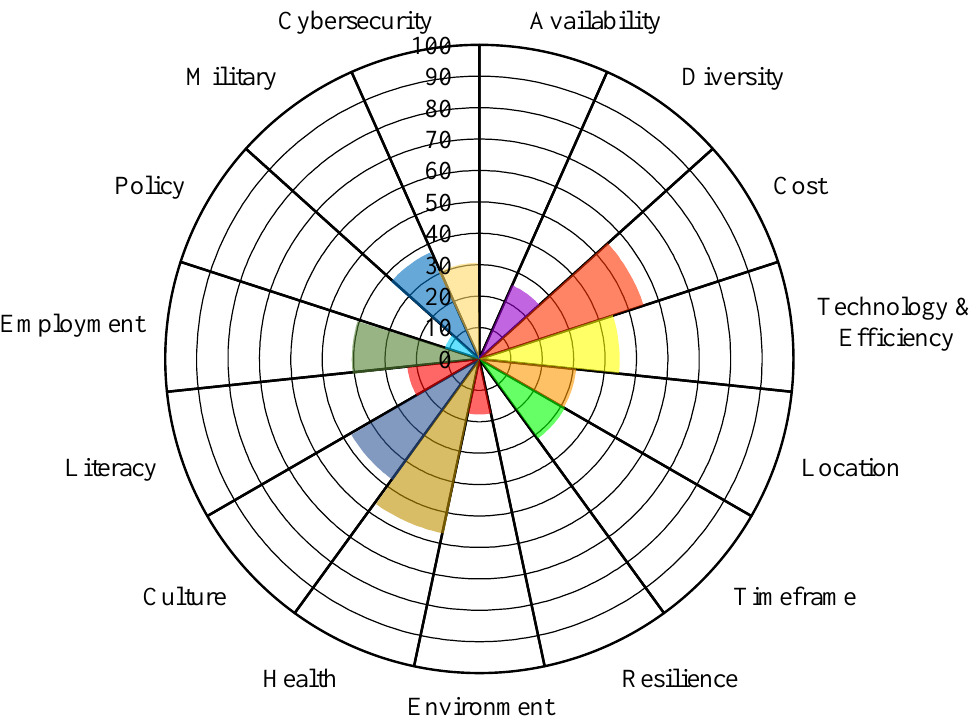
Figure 23. Detailed energy security view for Turkmenistan, values 0–100 represent worst to best.